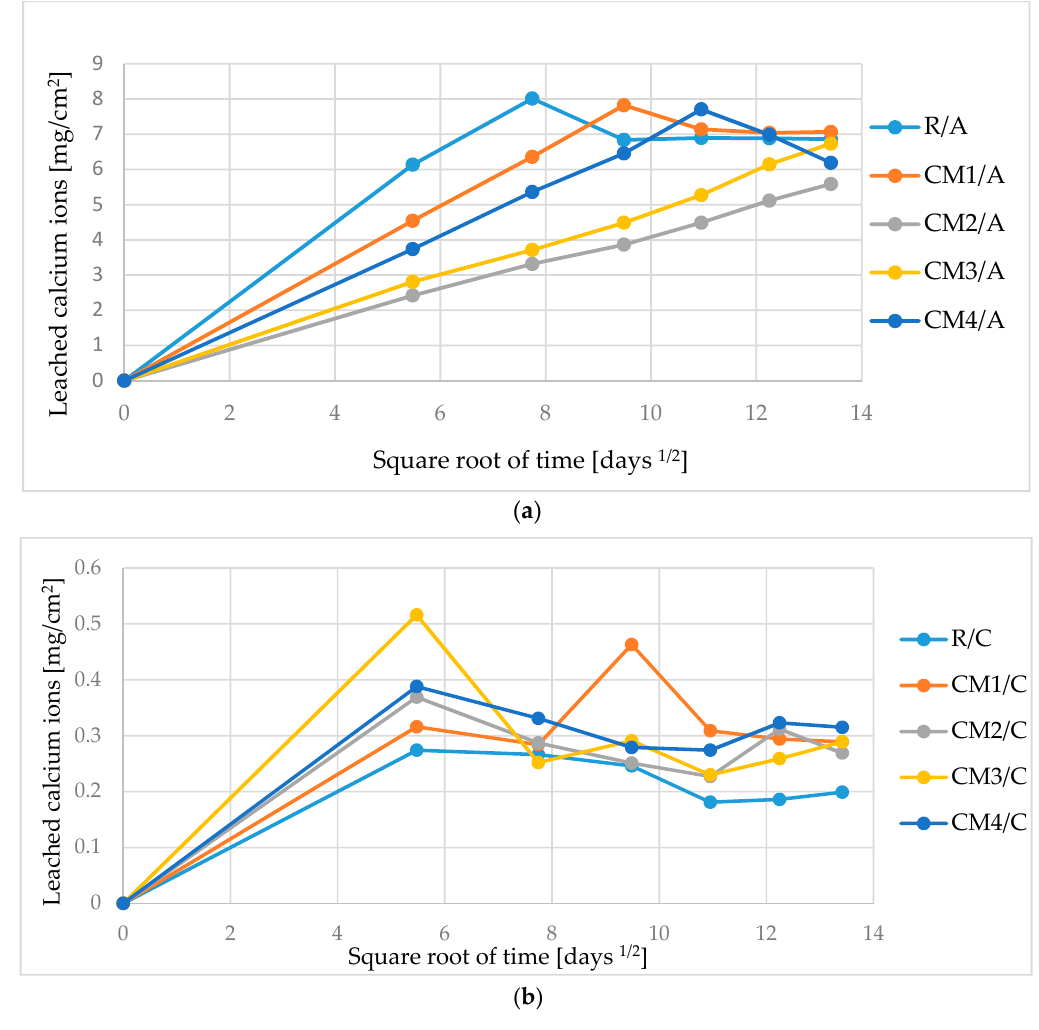
Figure 3. Leaching of calcium ions in ( a ) bacterial and ( b ) non-bacterial medium during the 180-day experiment.